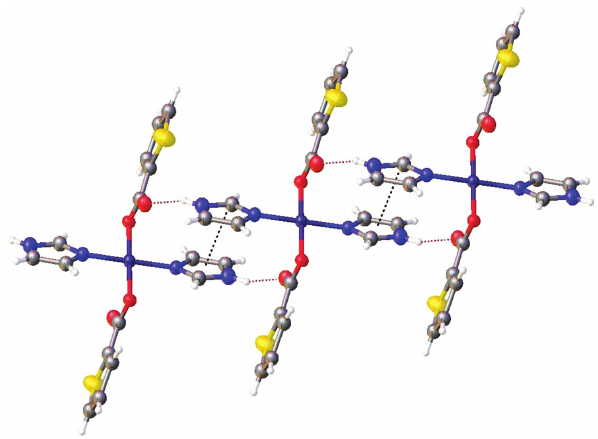
Figure 4 The N-H···O and π ··· π interactions in the copper